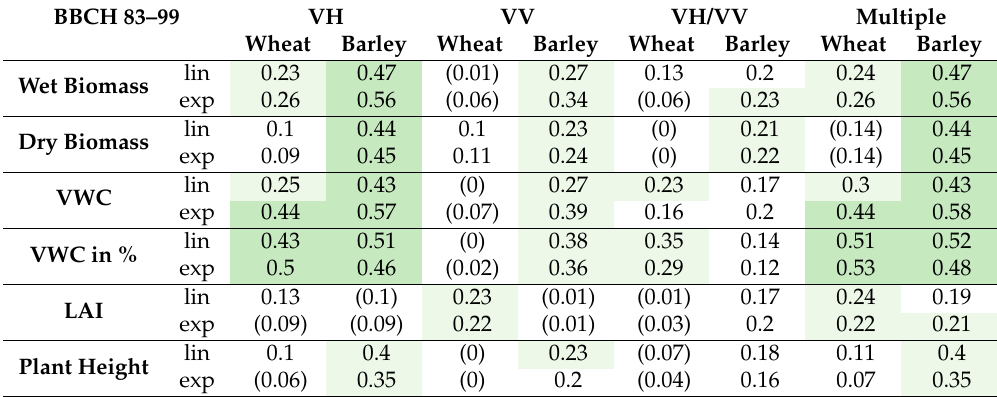
Table 6. R 2 values of the regression between crop and backscatter parameters per crop type for